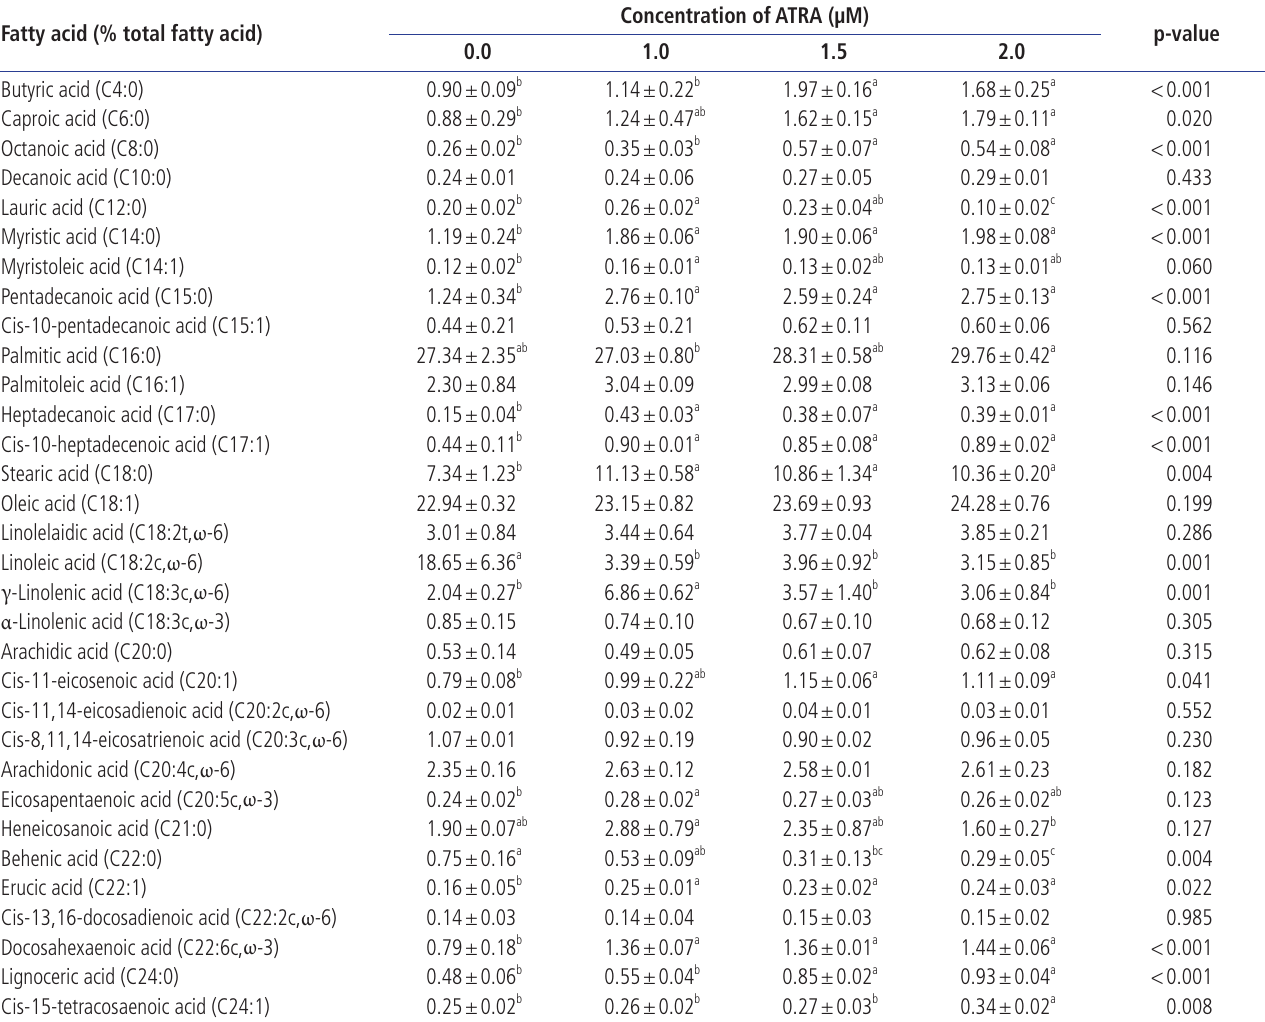
Table 2. Fatty acid composition of MAC-T cells treated with ATRA Fatty acid (% total fatty